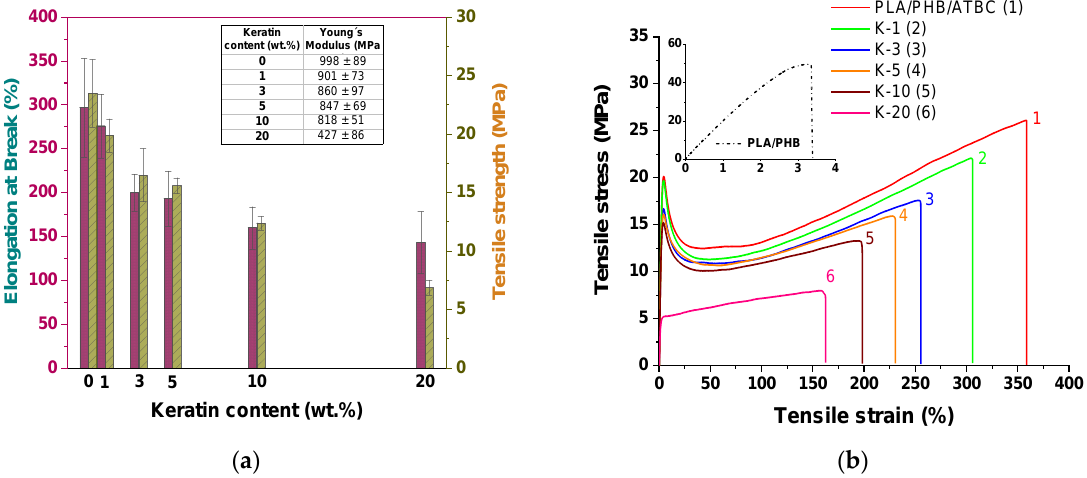
Figure 5. ( a ) Values of tensile properties ( ε B and σ M ) and Young’s modulus (inserted table) and ( b ) stress–strain curves for PLA/PHB/ATBC blend and its keratin composites with different keratin contents varying from 1 to 20 wt%. The inset of Figure 5b shows the stress–strain curve for PLA/PHB blend.